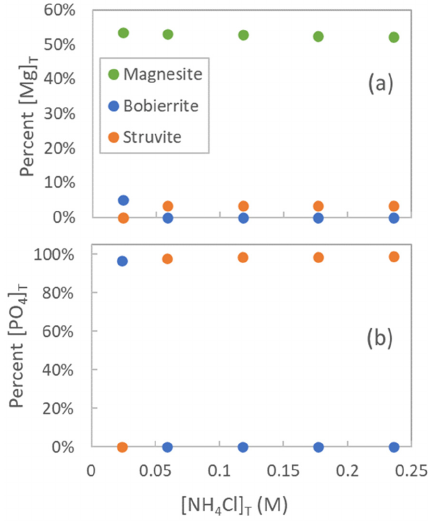
Figure 2. Percent [Mg] T and [PO 4 ] T for magnesite, bobierrite, and struvite. Symbols are the concen- tration of each solid (calculated by MINEQL+) divided by ( a ) [Mg] T and ( b ) [PO 4 ] T , then multiplied by 100%.